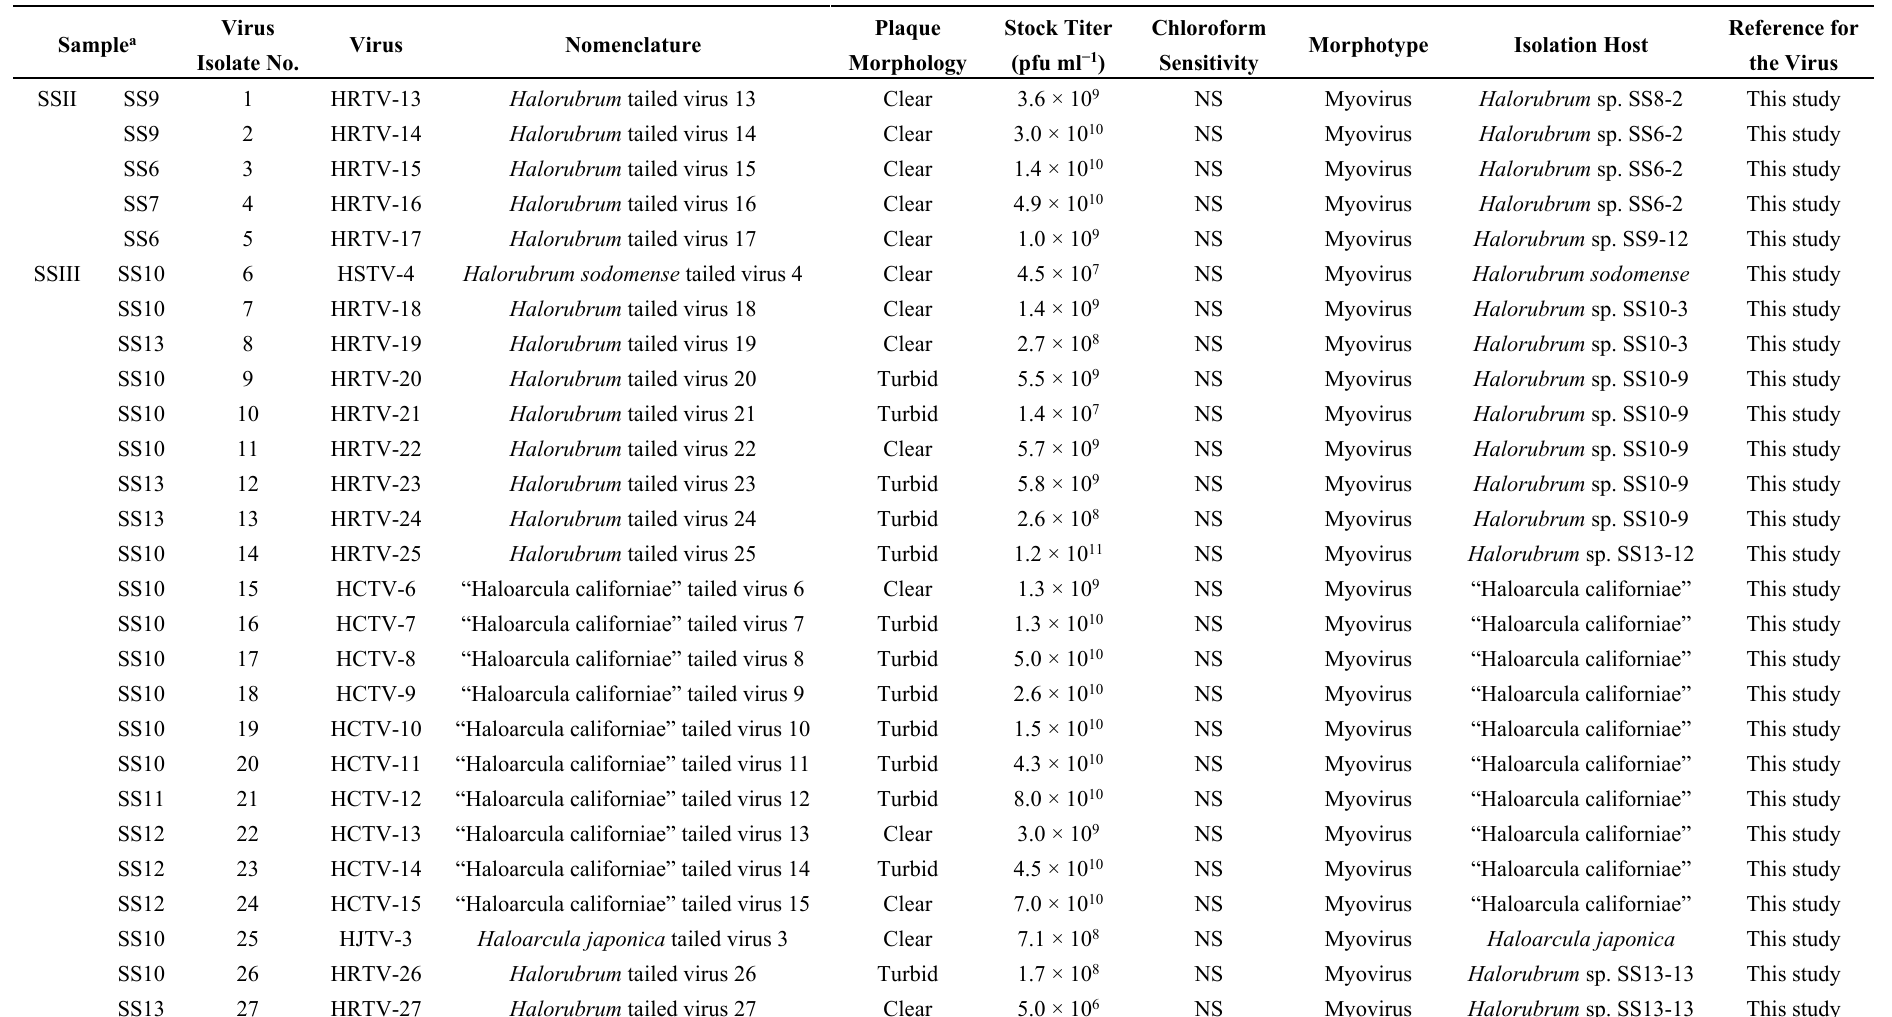
Table 2. Viruses used in this